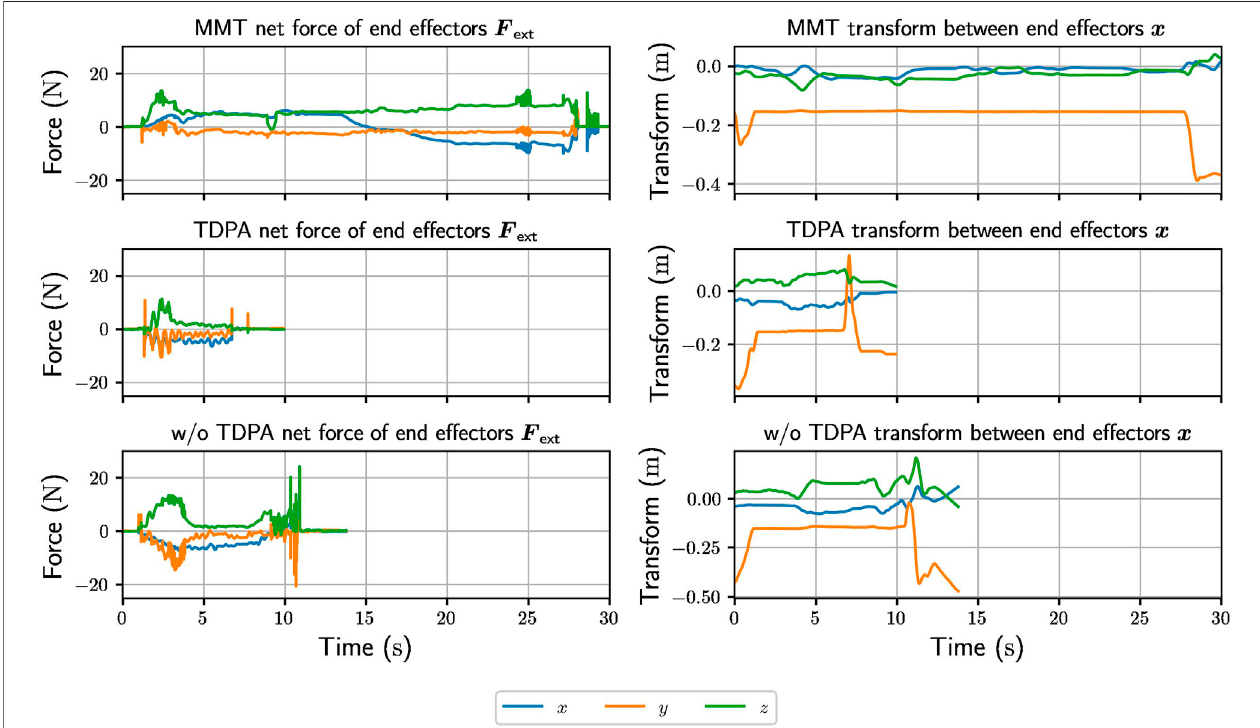
FIGURE 9 | The graphs in the left column show the net force of the estimated external wrenches acting on GARMI ’ s end effectors during the teleoperatoin task of thethirdexperiment.Thecolumnontherightdisplaysgraphsofthedisplacementbetweentheendeffectors.Notethattheforceanddisplacementinducedbythegrasp are primarily expressed around the y -axis of this experiment. The MMT method allowed for the successful completion of the task, while the oscillations and instability of the PFC architecuteres with and without TDPA respectively resulted in the grasp being released before the task could be completed.